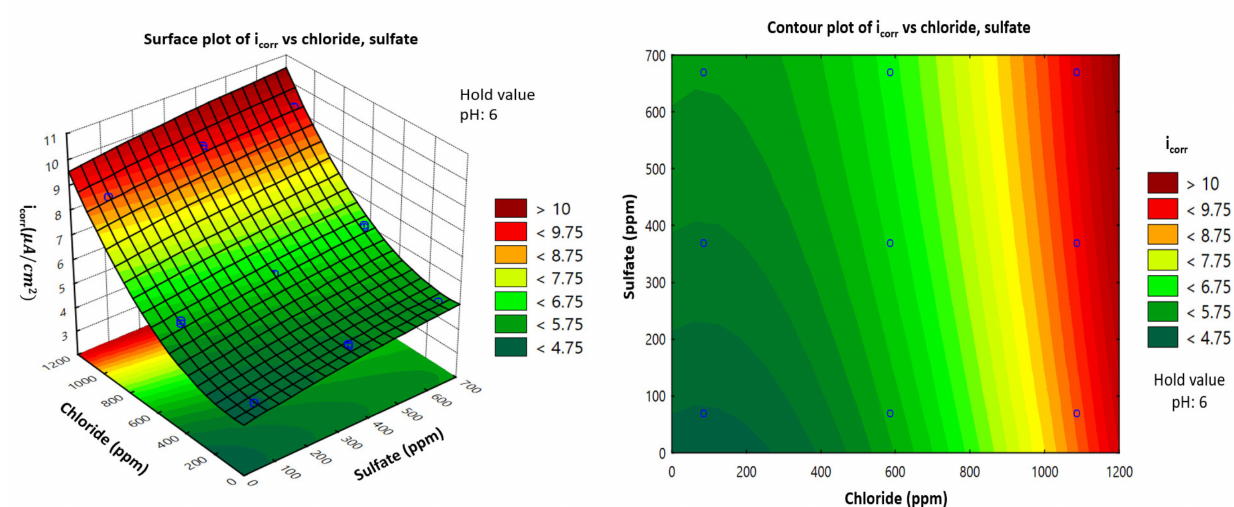
Figure 7. Response surface and contour plots showing the effect of chloride and sulfate concentrations on the corrosion current density ( i corr ) of carbon steel in a soil